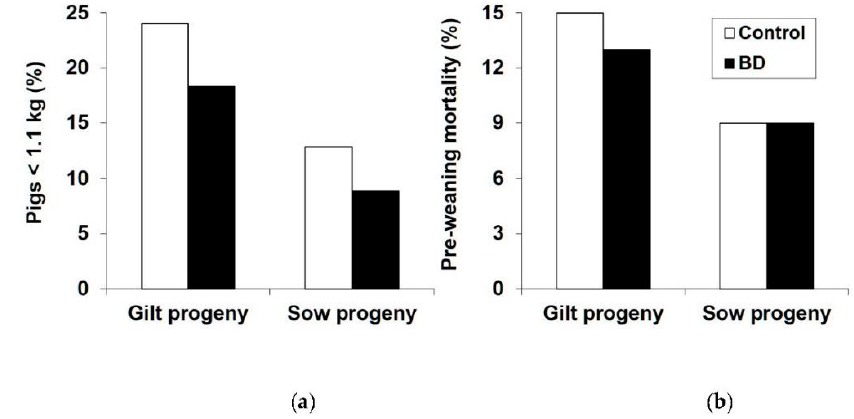
Figure 1. Effect of parity and diet (control vs. 1,3-Butanediol (BD) on: ( a ) Percentage of pigs that are small-for–age at birth ( < 1.1 kg); ( b ) Pre-weaning mortality. See text for statistical analysis.